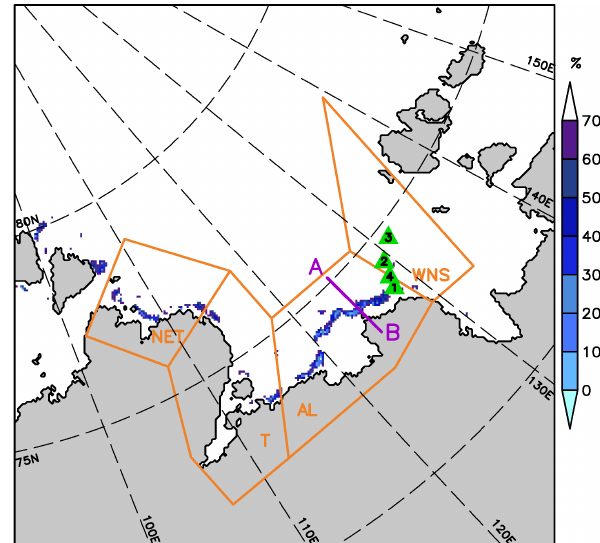
Figure 2. Model domain at 5km resolution (C05) over the Laptev Sea (approximately 1500km × 1500km) with the sea-ice concen- tration from AMSR-E showing open polynyas ( ≤ 70%) on 4 Jan- uary 2008. Four polynya regions are superimposed as orange poly- gons: north-eastern Taimyr polynya (NET), the Taimyr polynya (T), the Anabar–Lena polynya (AL), and the western New Siberian polynya (WNS). A → B denotes the 214km long cross section (ma- genta) used in Sect. 5. The locations of the four AWS stations are marked with green